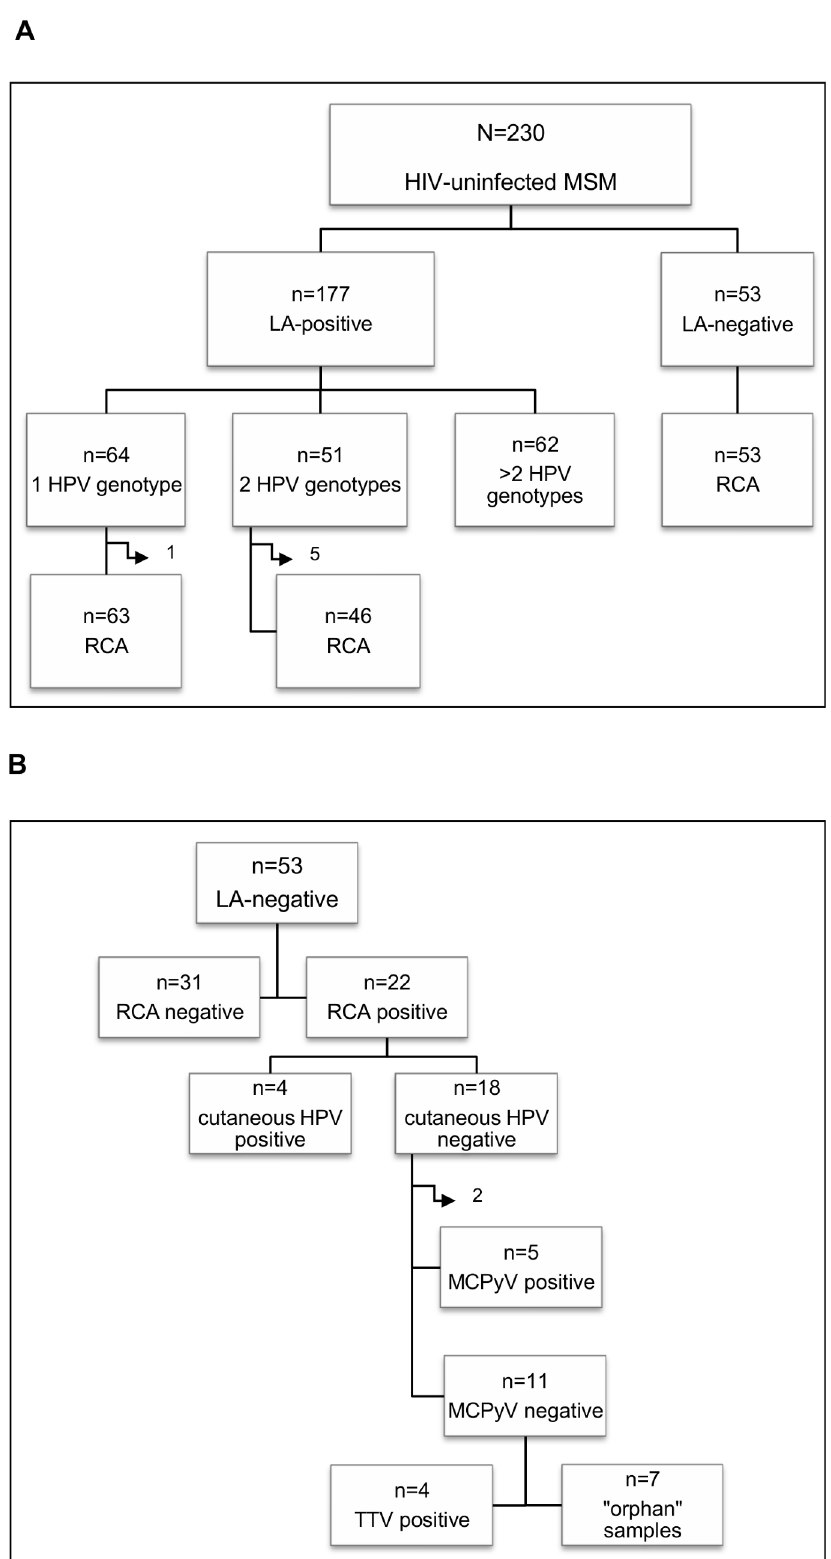
Figure 1. Genotype-specific prevalence of anal HPV infection. High-risk, possibly and probably high-risk types were considered as high-risk HPV, while low-risk and undetermined types were considered as low-risk HPV.